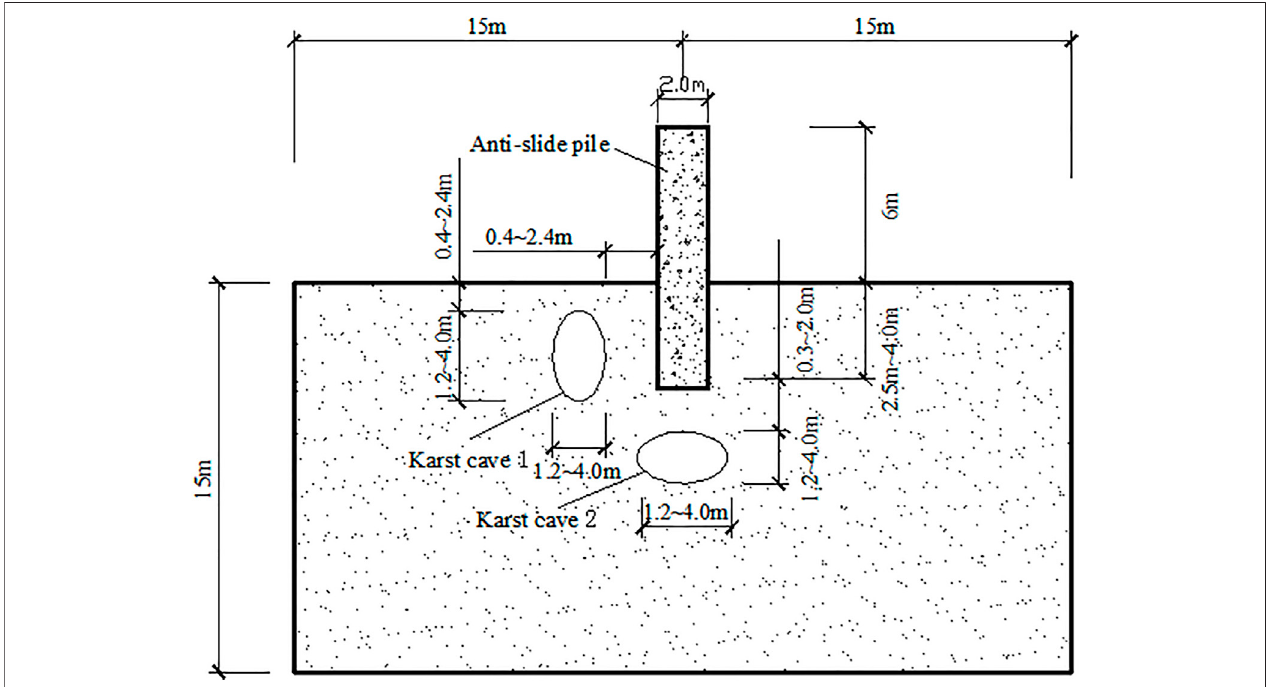
FIGURE 1 | Schematic diagram of the model ’ s geometric parameter values.